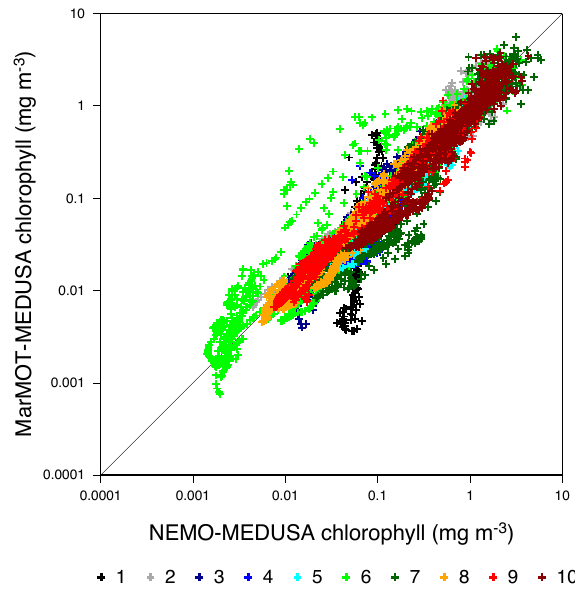
Figure 4. Five-day mean surface chlorophyll output for 1998 at all 12 sites from the uninformed simulator, compared with that from the matching 3-D NEMO-MEDUSA reference simulation. Results are shown for the 10 different parameter vectors in Table 2, colour coded by Parameter Set